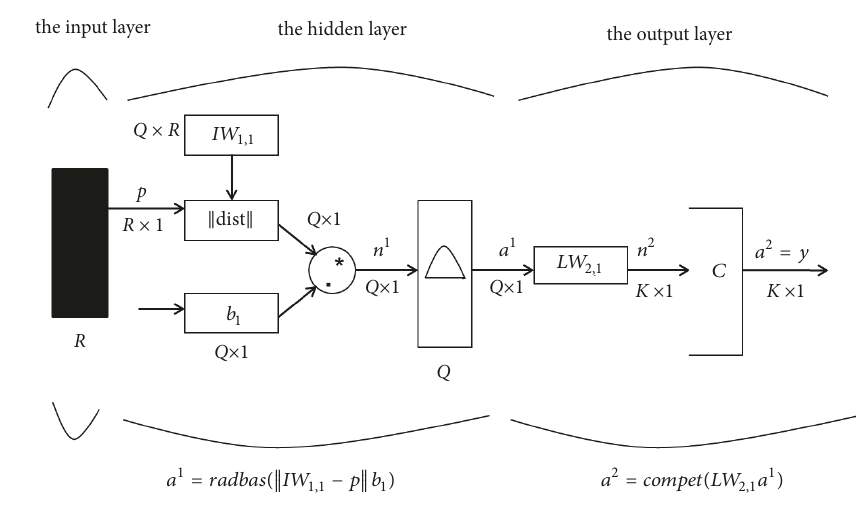
Figure 6: Structure of the